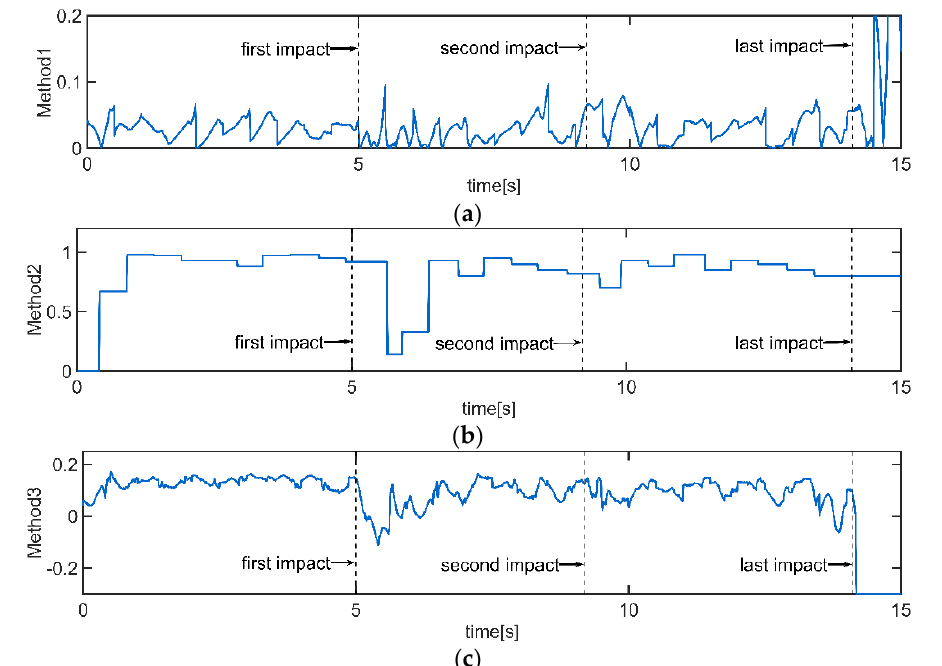
Figure 32. Stability measurements of the motion on slope under the three methods: ( a ) Method 1; ( b ) Method 2; and ( 3 ) Method 3.